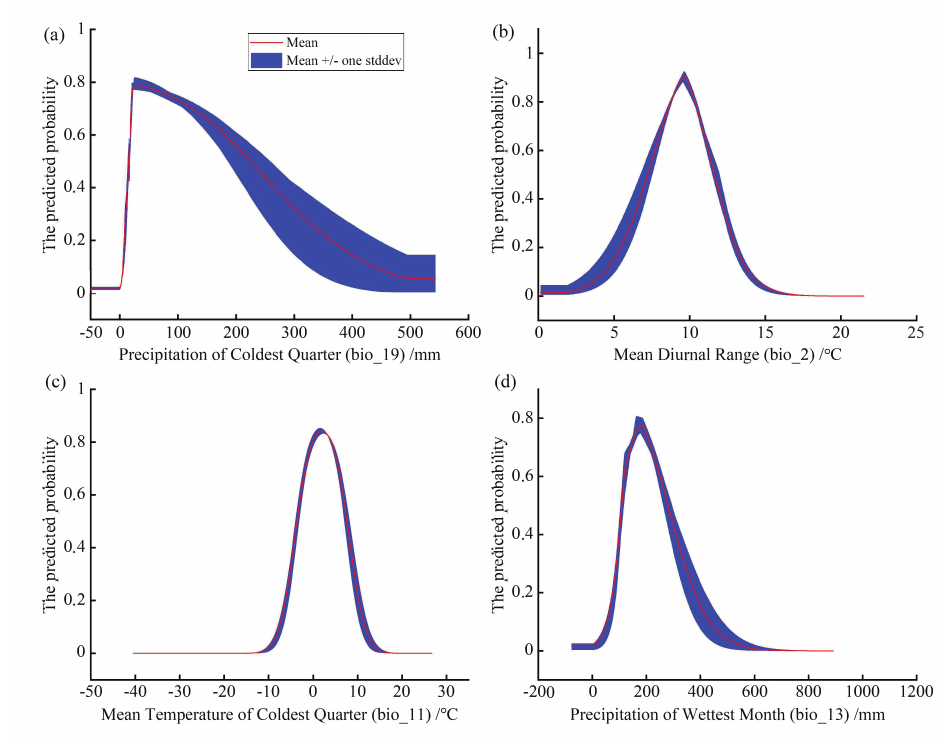
Figure 8. The response curve of the dominant environmental factors. Panel ( a ) indicates that of bio_19; ( b ) indicates that of bio_2; ( c ) indicates that of bio_11; ( d ) indicates that of